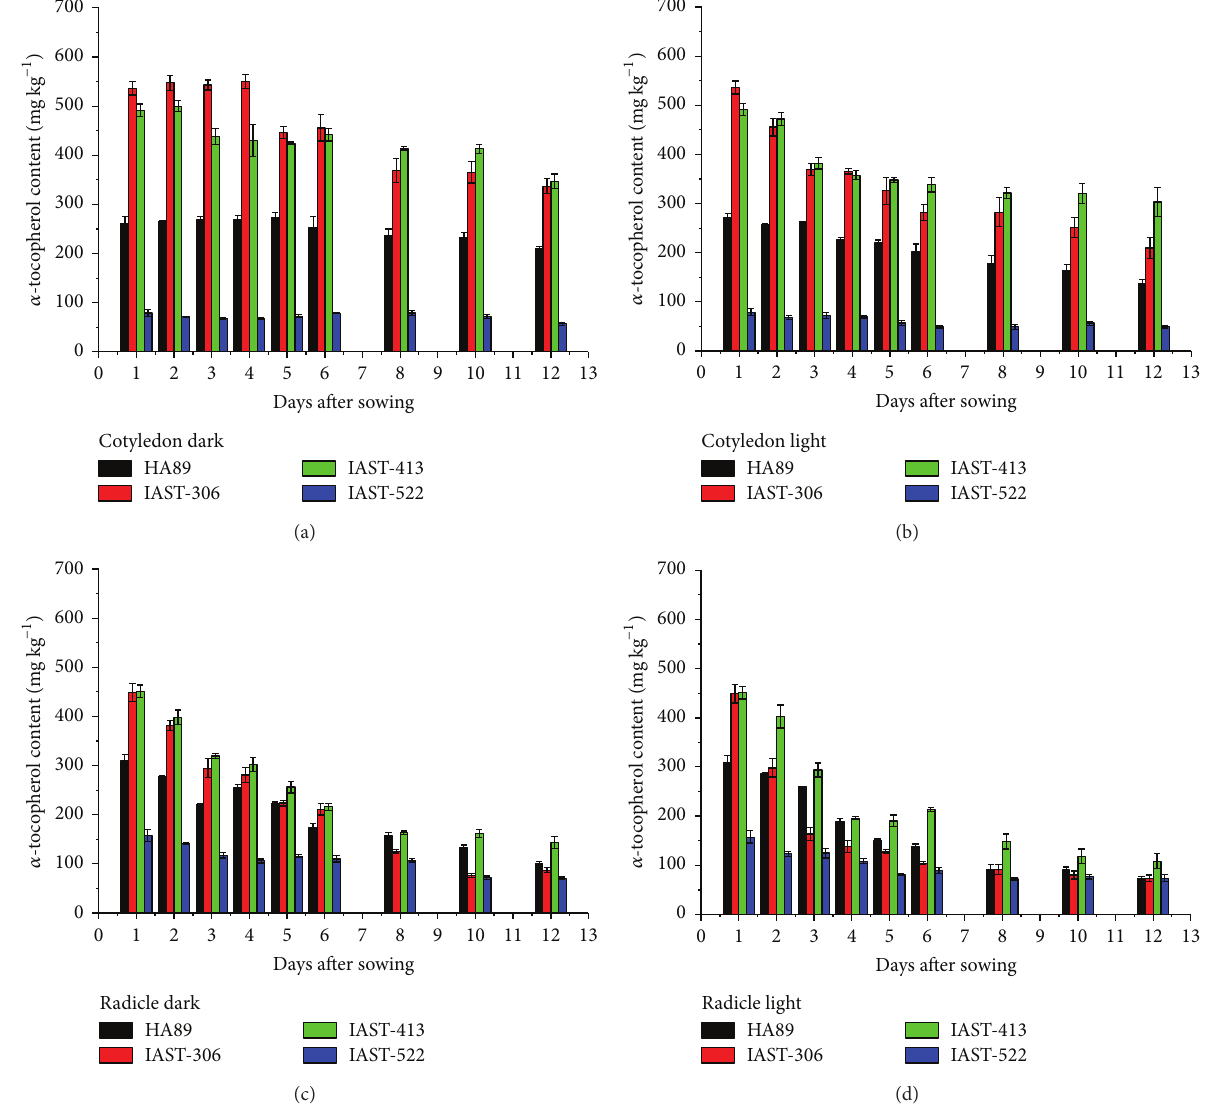
Figure 1: 𝛼 -tocopherol content (mgkg −1 dry tissue) from 1 to 12 days after sowing in cotyledons and radicles of sunflower lines HA89, IAST- 306, IAST-413, and IAST-522, with contrasting levels of seed tocopherol content predominantly in the 𝛼 -tocopherol form, from seedlings grown under dark and light conditions. Data are presented as mean ± standard error of three